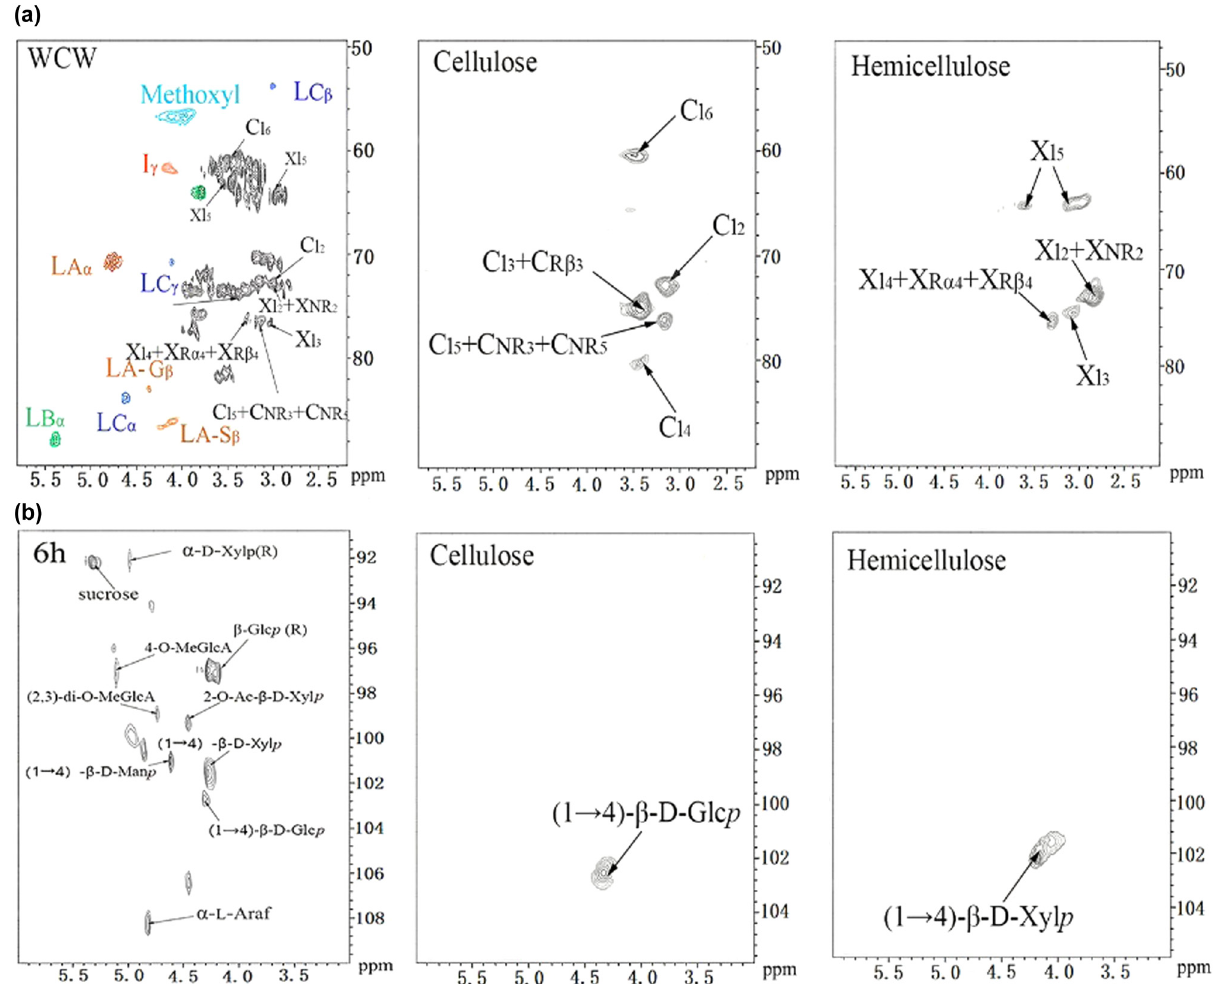
Figure 8: Anomeric regions of HSQC spectra of tobacco leaf cell walls and isolated cellulose and hemicellulose from tobacco leaf in DMSO - d 6 /HMPA - d 18 . ( a ) Non - anomeric region, ( b ) anomeric